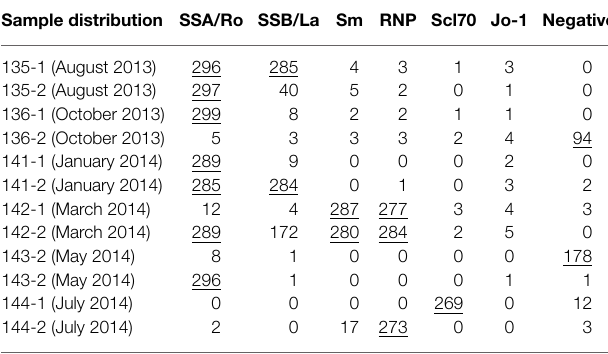
TABLE 2 | Number of specific responses for UK NEQAS dispatches for anti-ENA during 1year (August 2013–July 2014)